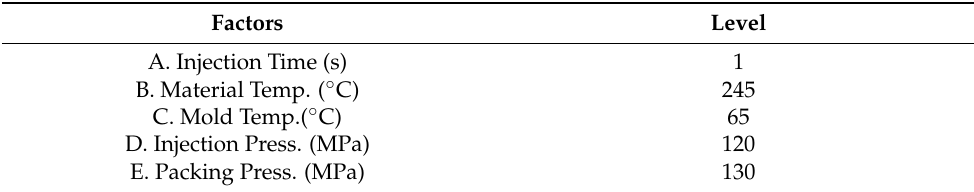
Table 2. Original Process Parameters.